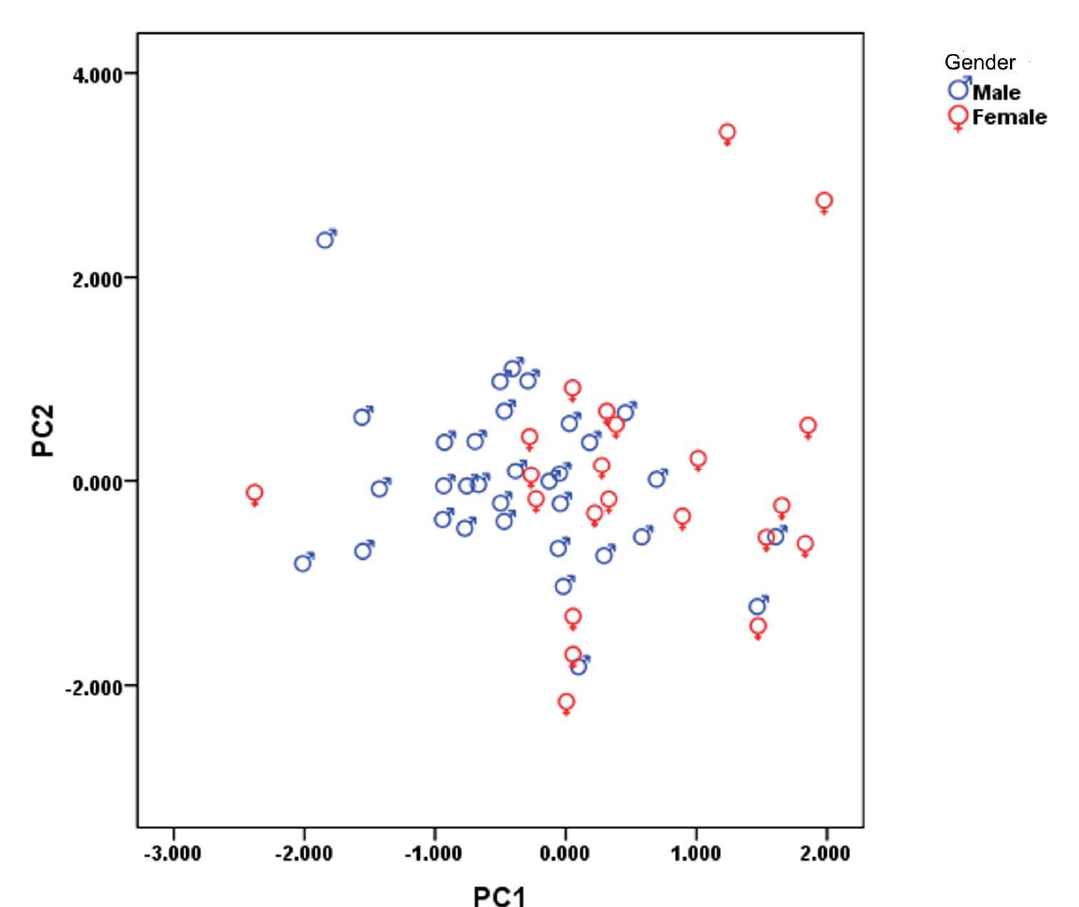
F IGURE 1. Ordination of the individual males and females of Hyla savignyi on the first two principal components. Note the relative degree of isolation between the